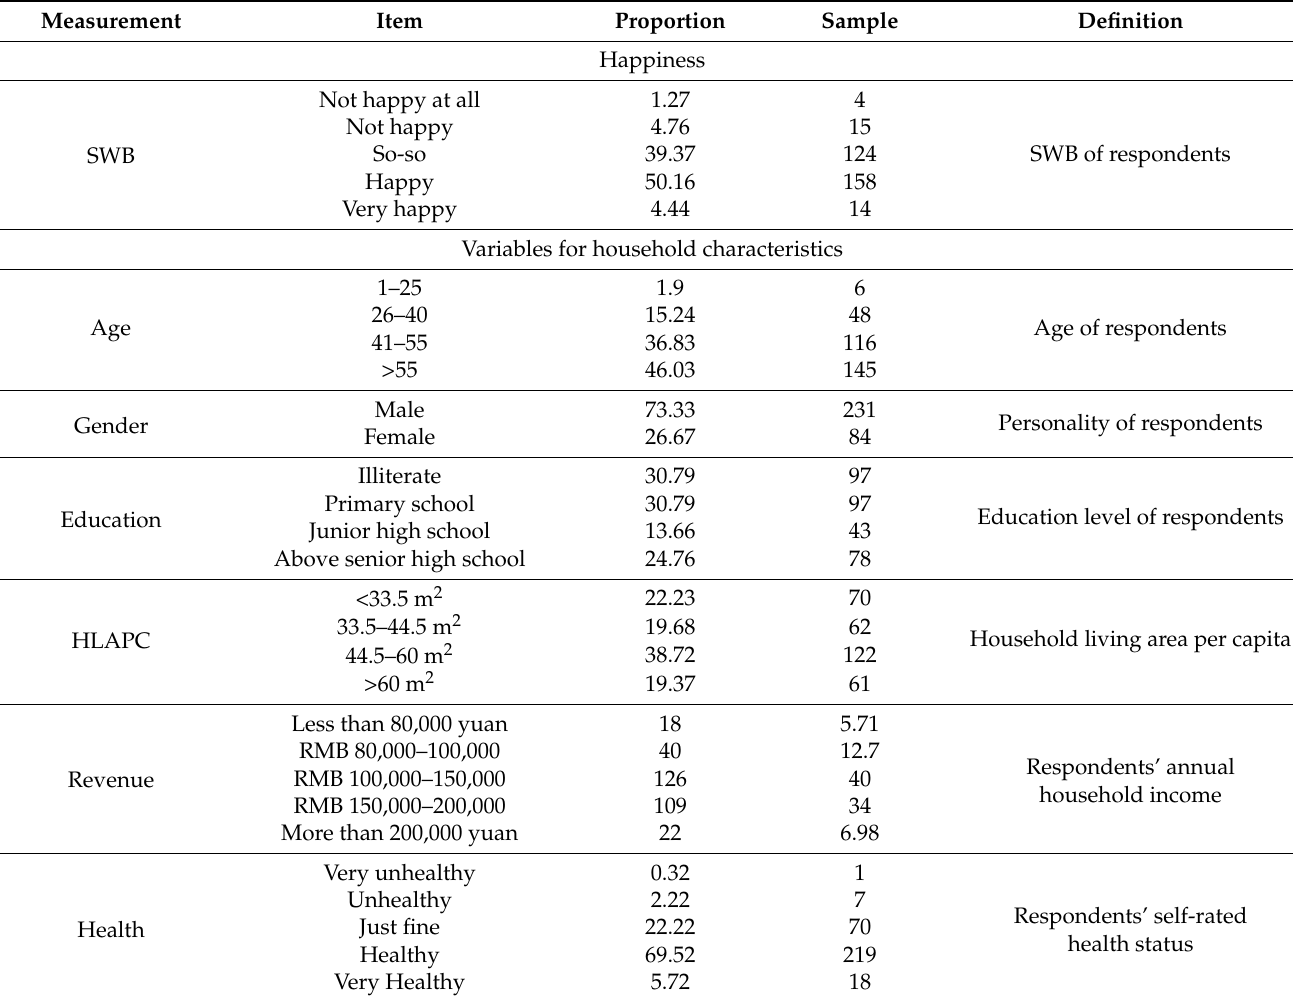
Table 2. Descriptive statistics of valid